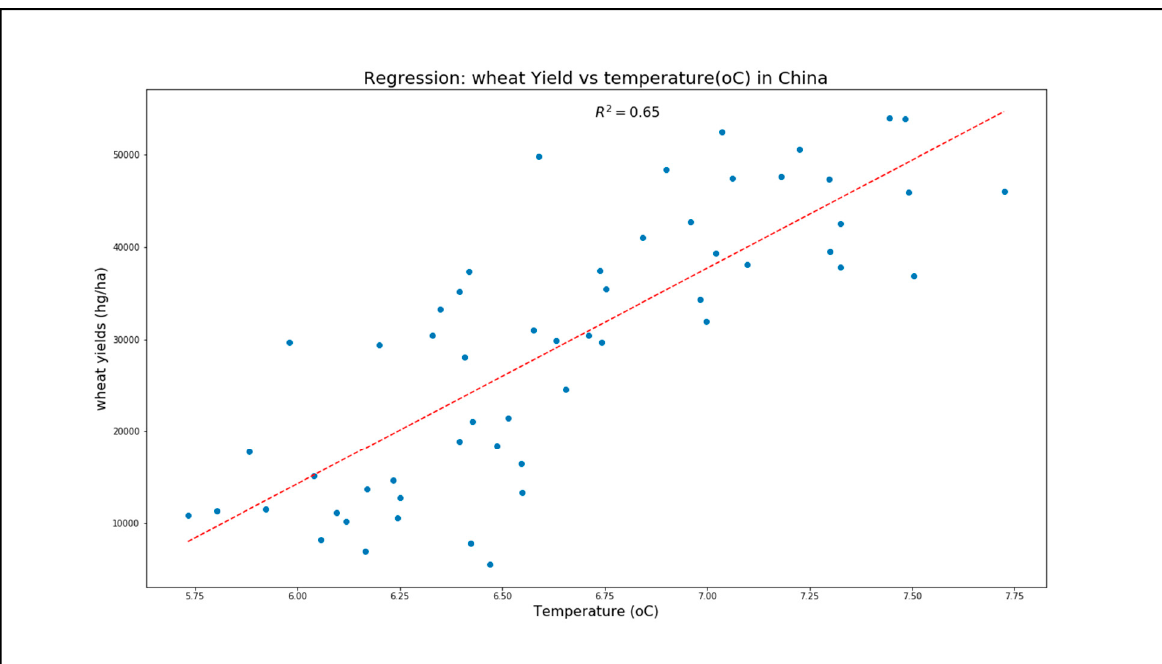
Figure 6. Crop yield—Wheat vs. temperature (in °C) in China.